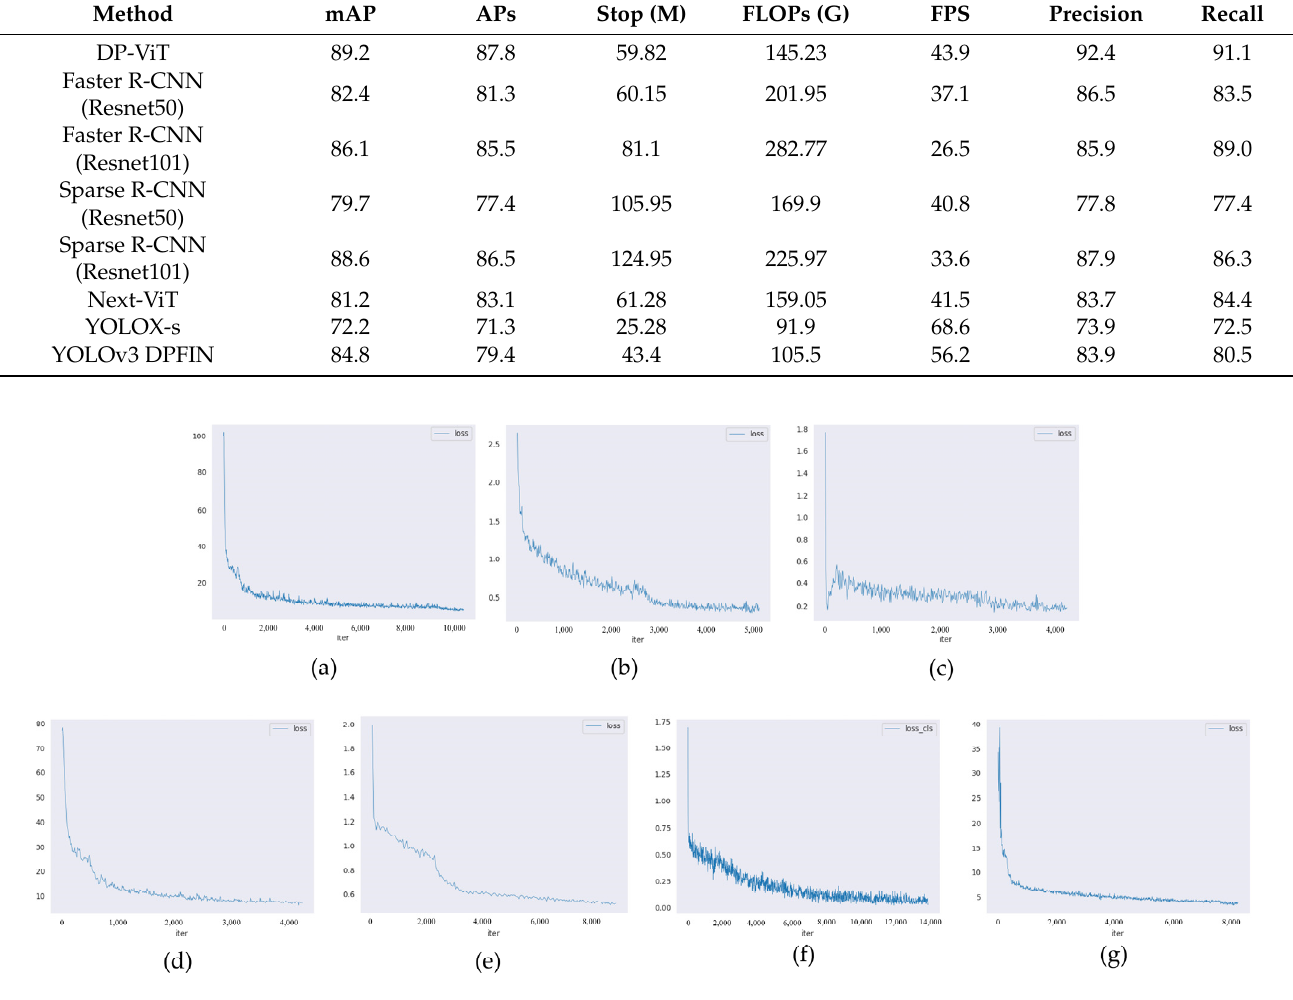
Figure 7. Loss comparison chart of each method.( a ) Our method:DP-ViT ( b ) Faster R-CNN(Resnet 50) ( c ) Faster R-CNN(Resnet 101) ( d ) Sparse R-CNN(resnet 50) ( e ) Sparse R-CNN(resnet 101) ( f ) Next-ViT